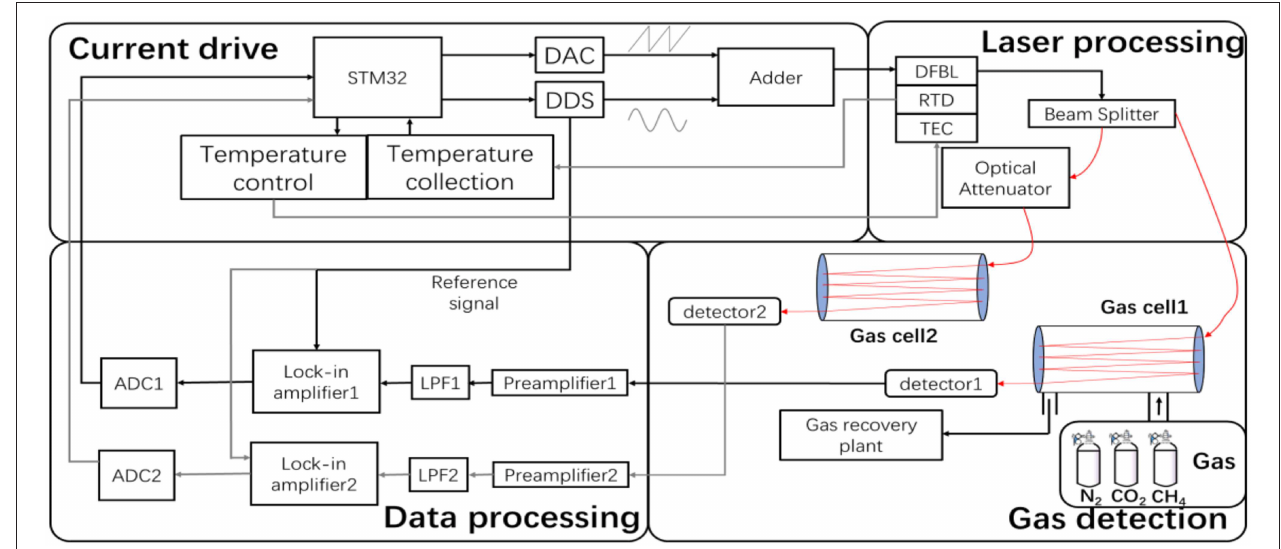
FIGURE 4 | Structure of the CO 2 gas detection system. The red line represents a single mode fiber. The black line and the gray line represent the electrical